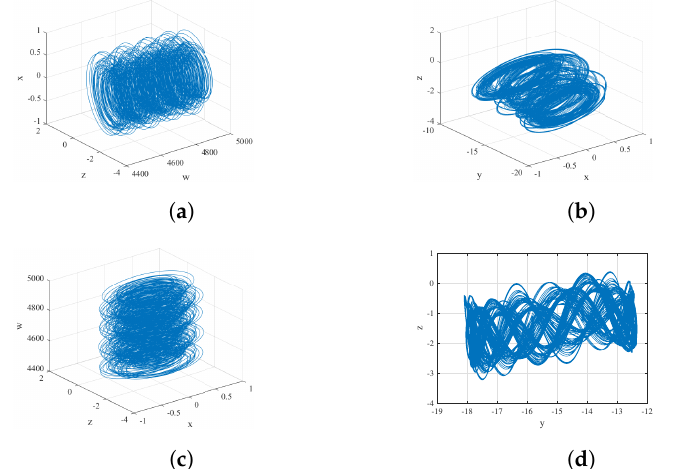
Figure 10. Phase portraits of the hyperchaotic state when r = 15.25 and g = 5 ( a ) w - z - x plane ( b ) x - y - z plane ( c ) x - z - w plane ( d ) y - z